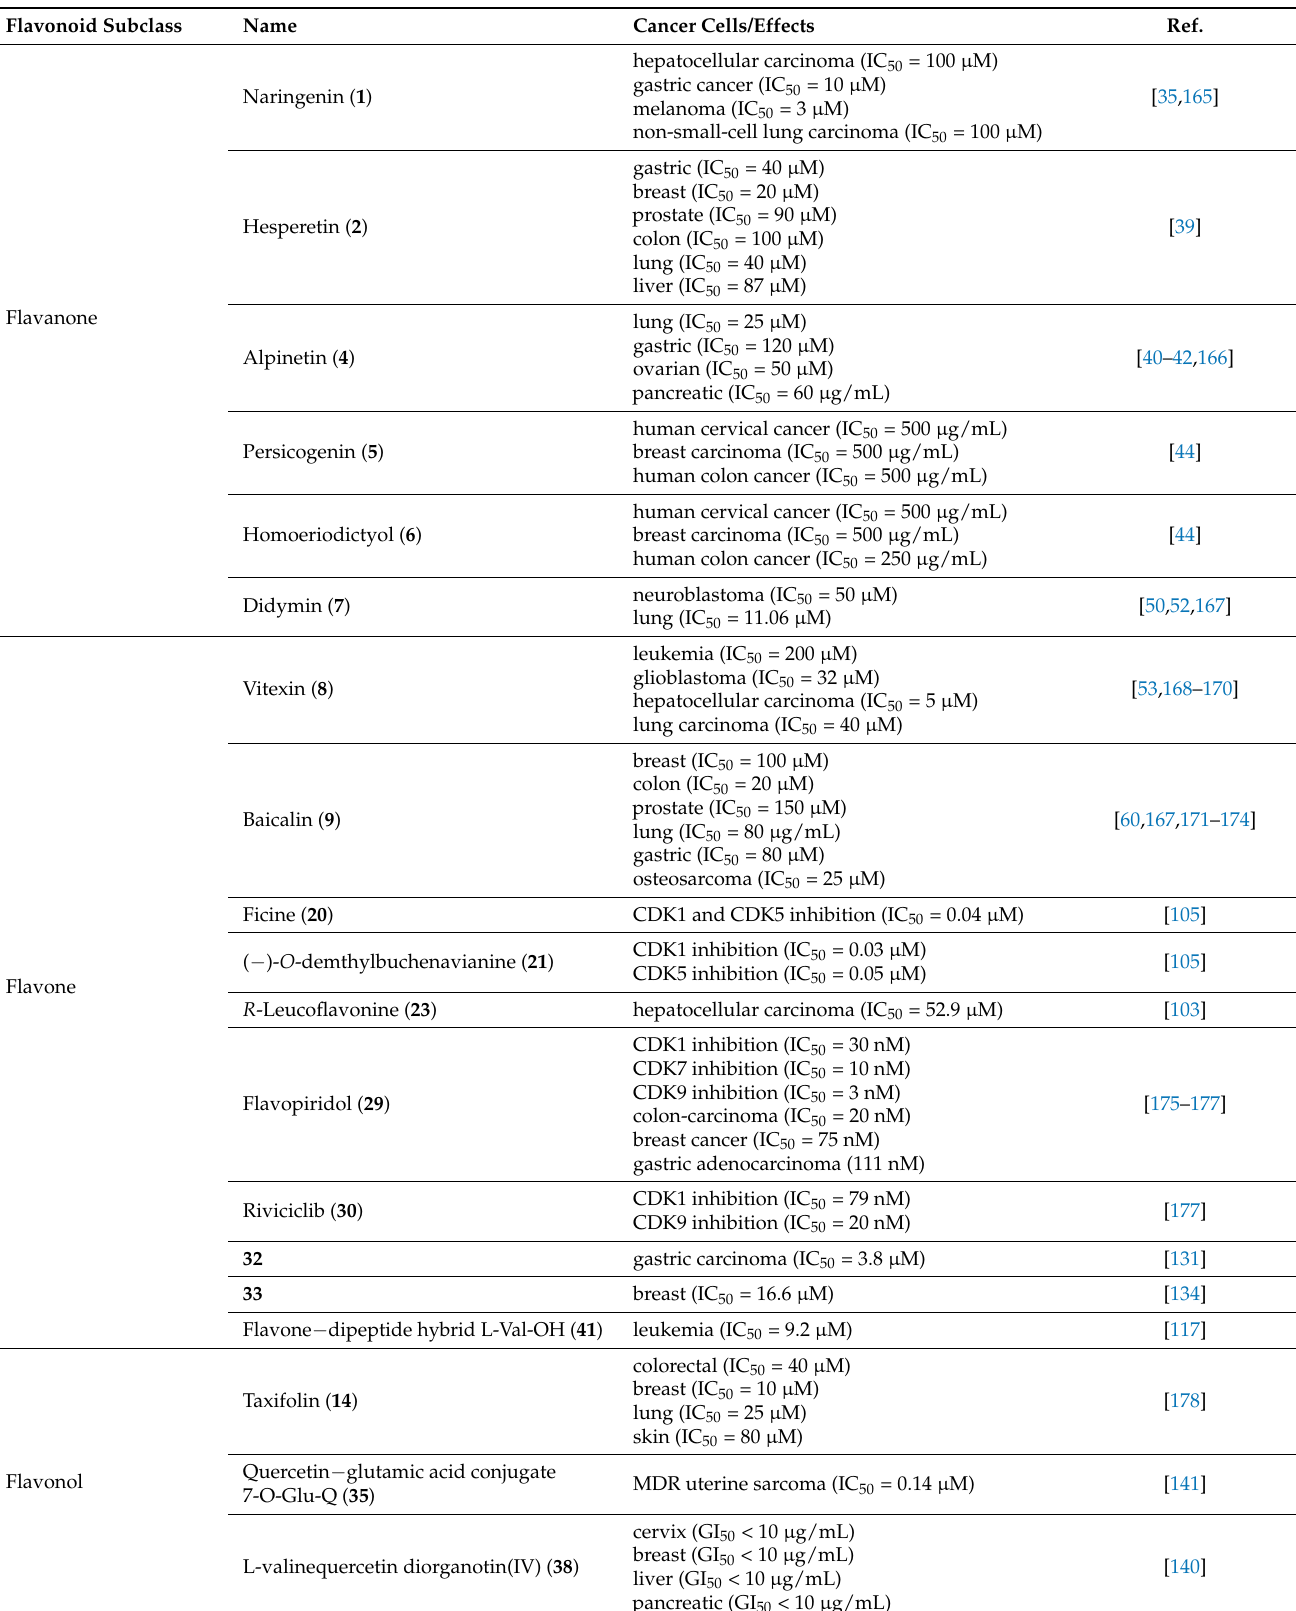
Table 2. Chiral flavonoids with antitumor